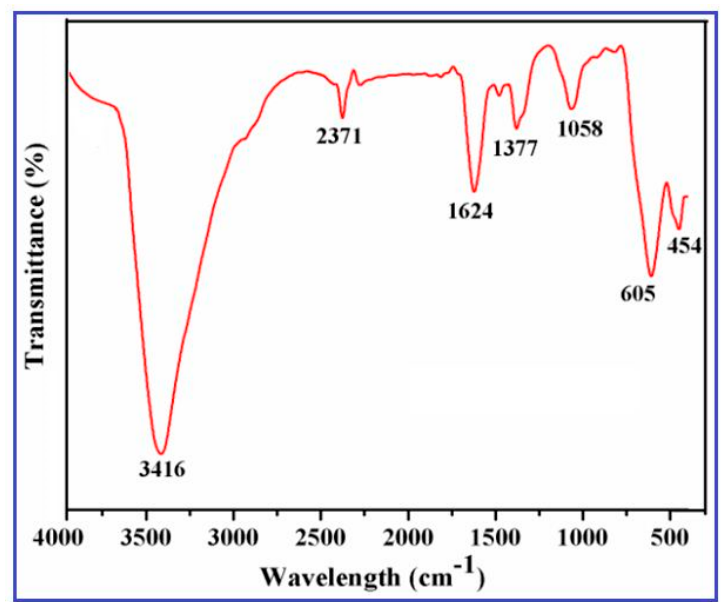
Figure 3. Fourier Transform Infrared Spectroscopy (FTIR) spectra of CuO nanowires synthesized using SMFE.